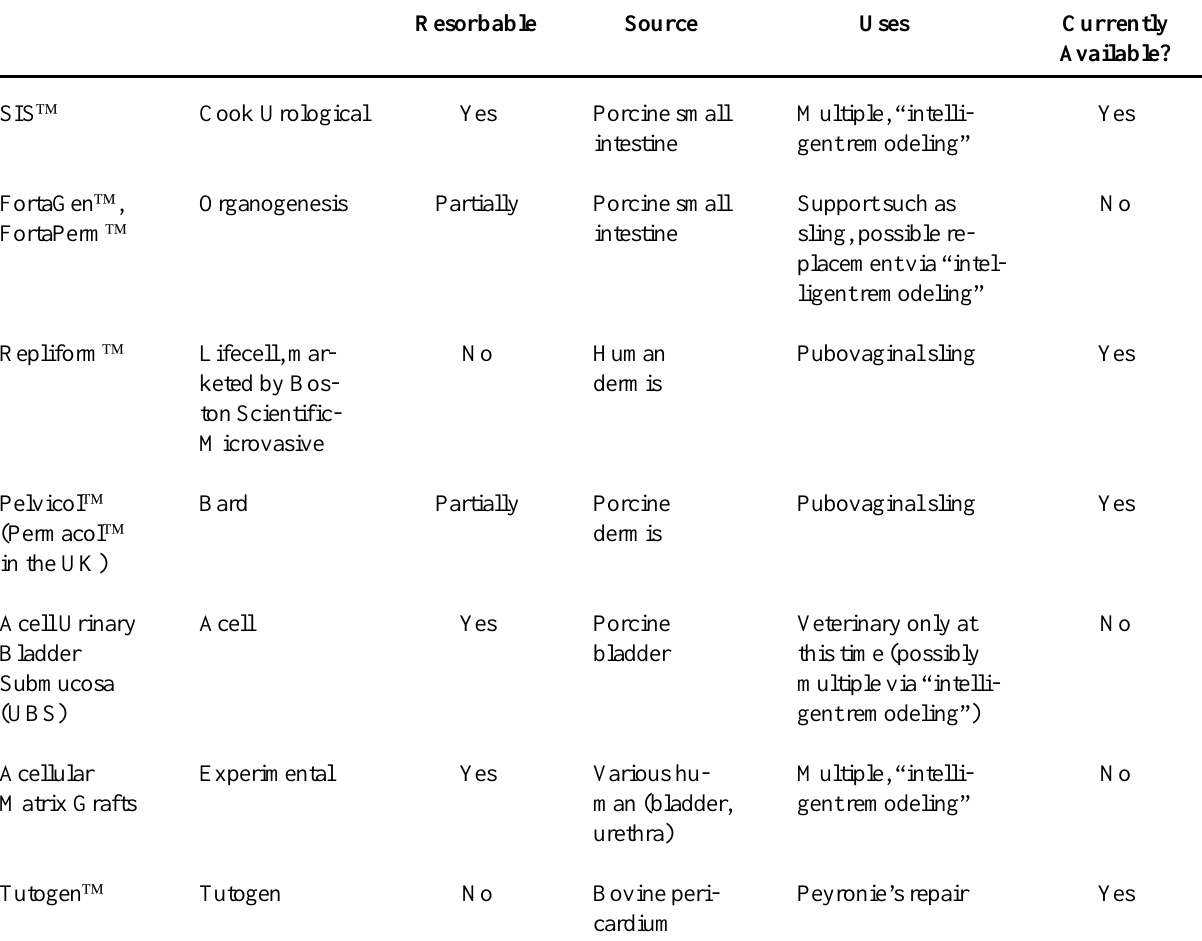
Table 1 – Comparison of various commercial and experimental